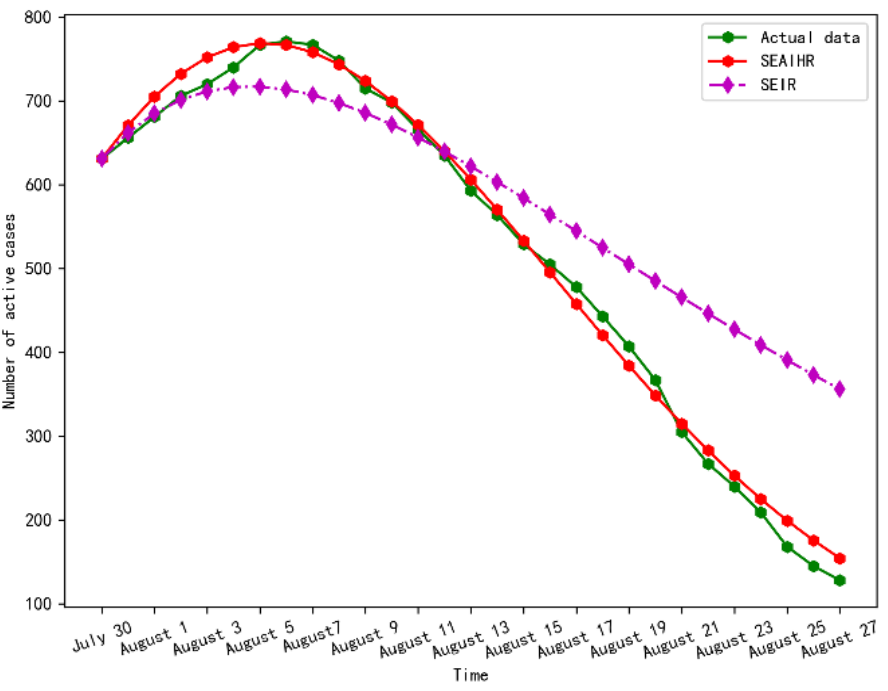
Figure 11. Epidemic prediction for the next four weeks. Figure 11. E pidemic prediction for the next four weeks.